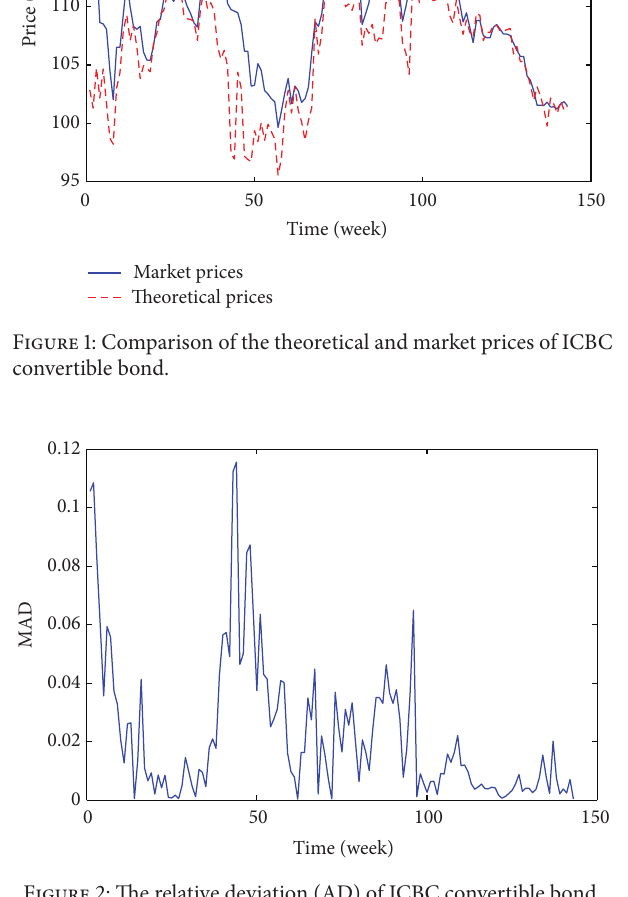
Figure 2: The relative deviation (AD) of ICBC convertible bond.